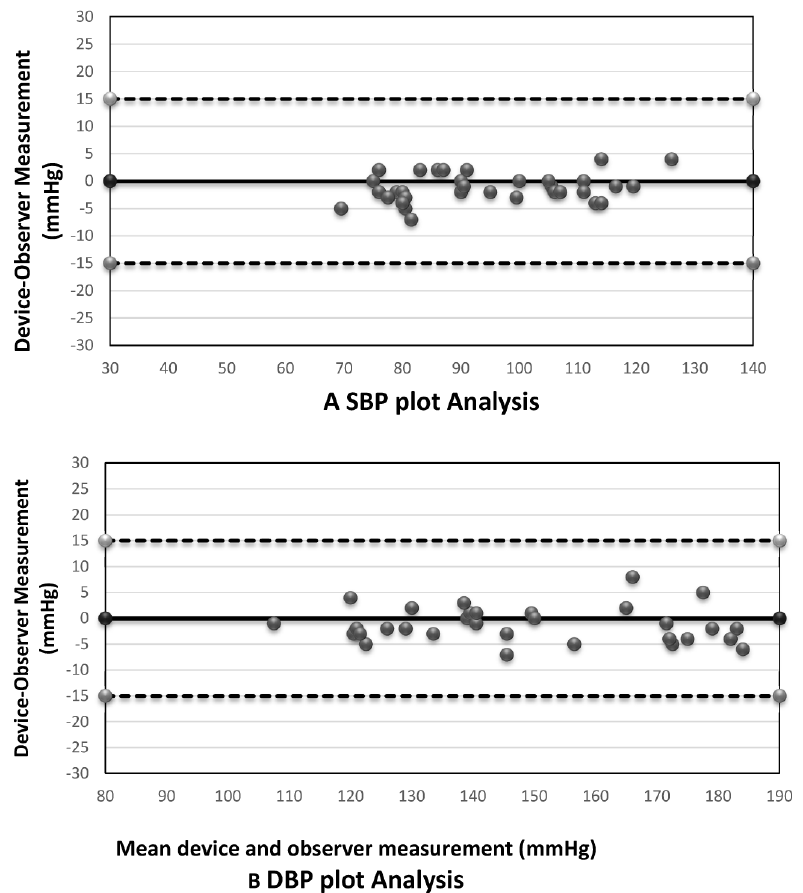
Figure 1. Bland–Altman plots of the differences between the BP measurements. ( A ) Systolic blood pressure; ( B ) diastolic blood pressure.